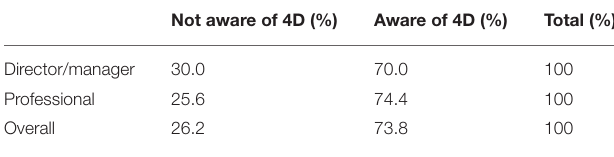
TABLE 6 | Awareness of 4D in industry.